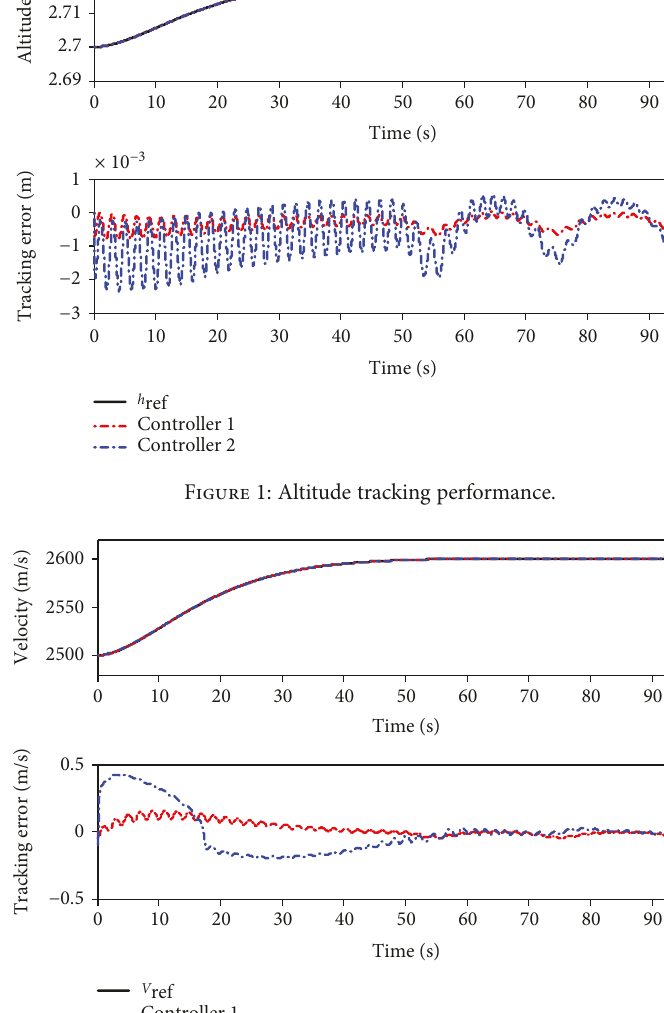
Table 1. The velocity step Δ V = 100 m/s , altitude step Δ h =